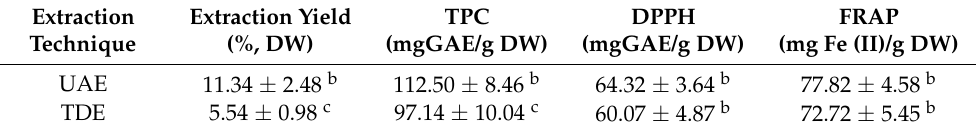
Table 1. Cont . Extraction Technique